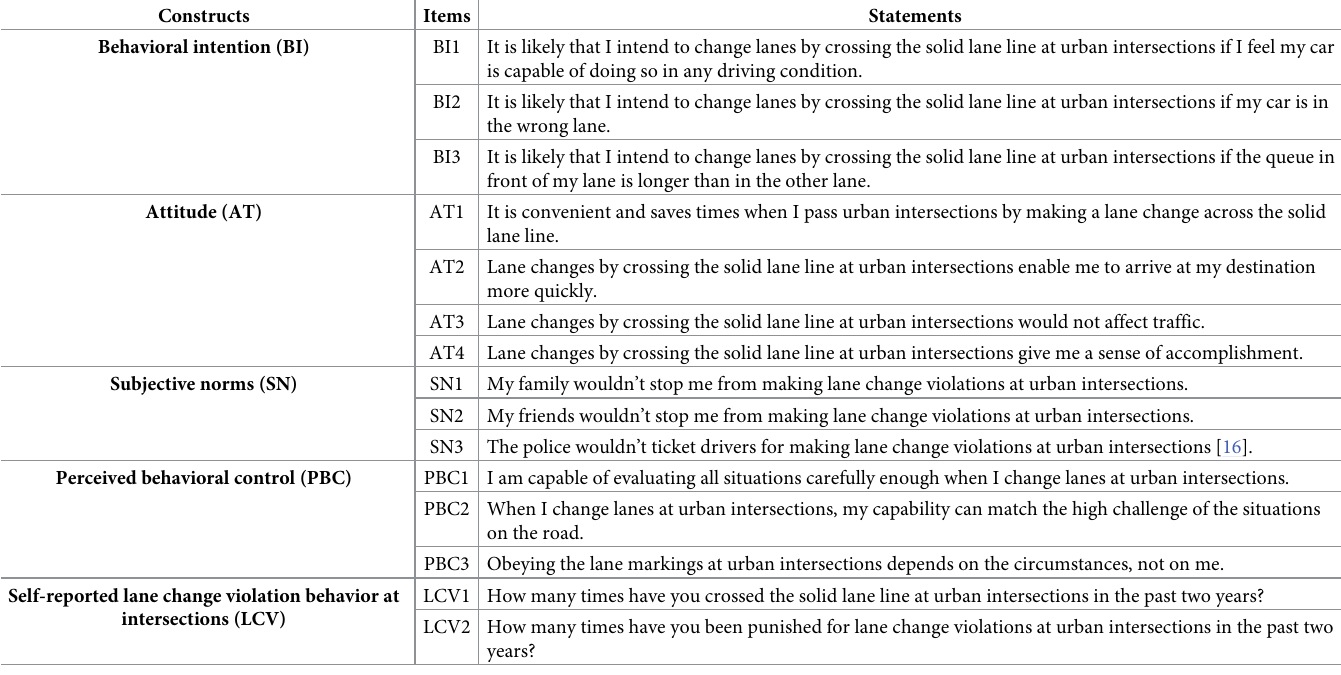
Table 3. Statements of constructs and corresponding items.